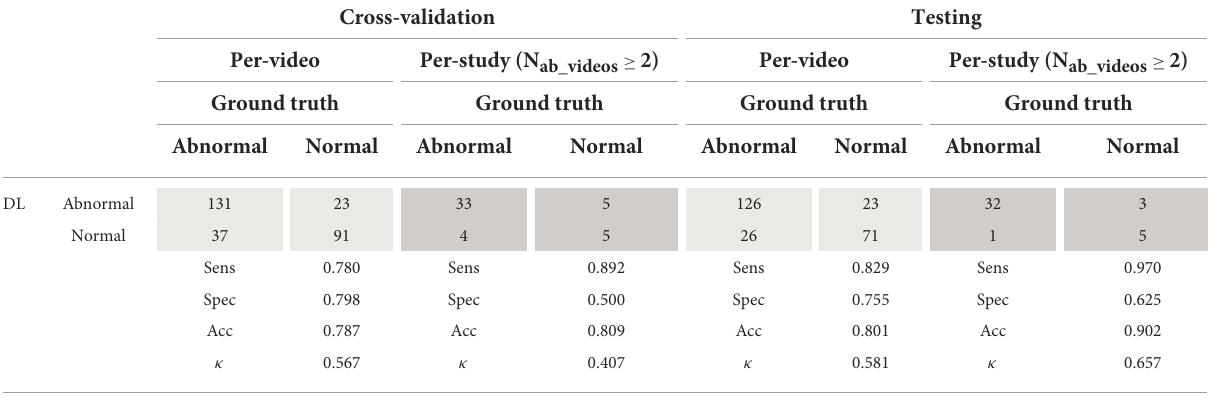
TABLE 2 DL classification performance in CT studies with 40 < LVEF < 60%.